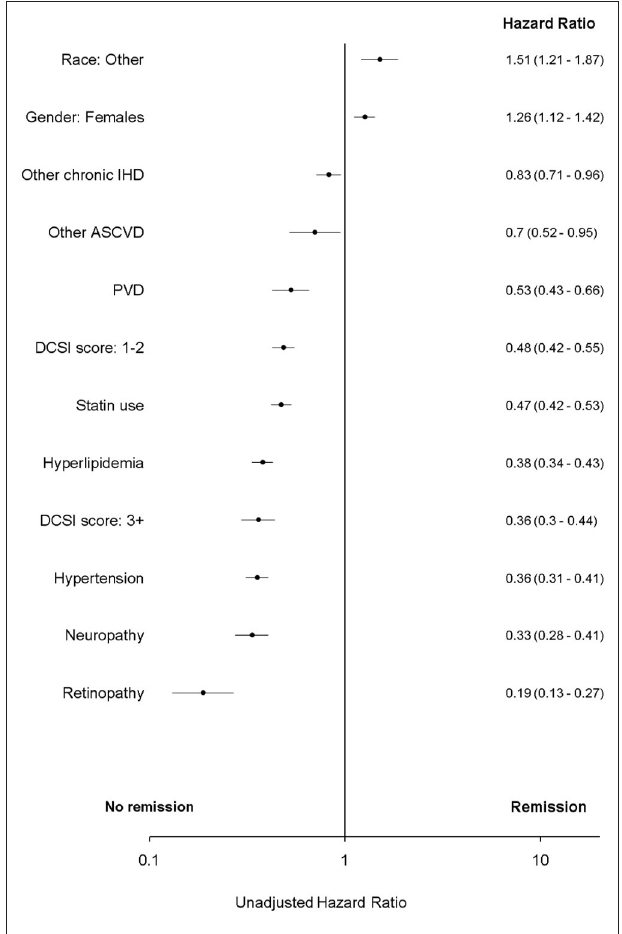
FIGURE 2 | Unadjusted Cox proportional hazard for T2DM “remission.” ASCVD, atherosclerotic cardiovascular disease; DCSI, Diabetes complications severity index; IHD, ischemic heart disease. Race, other, non-white and non-African American; PVD, peripheral vascular disease.